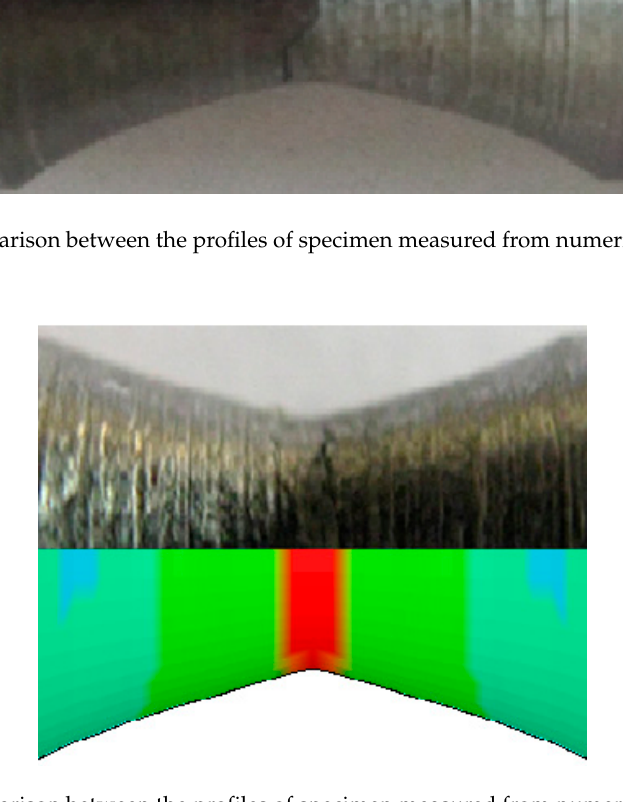
Figure 14. A comparison between the profiles of specimen measured from numerical simulation and dynamic test.